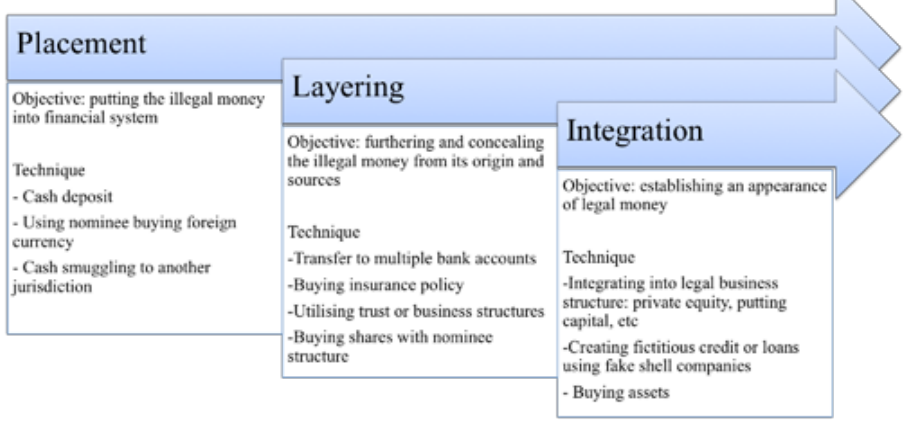
Figure 1: Stages of Money Laundering